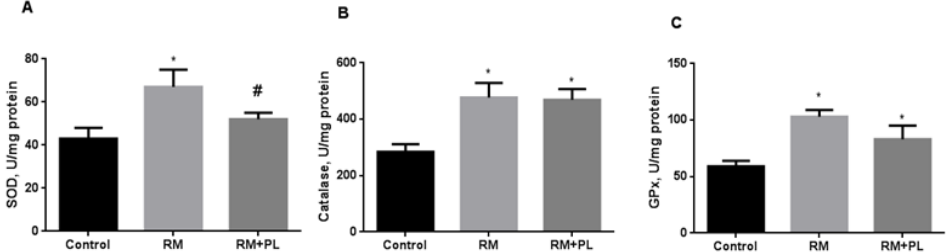
Figure 6. Changes in the activity of antioxidant enzymes in kidney tissue during rhabdomyolysis and PL administration: ( A ) SOD activity; ( B ) catalase activity; and ( C ) glutathione peroxidase activity. * p < 0.05 compared to control, # p < 0.05 compared to RM.